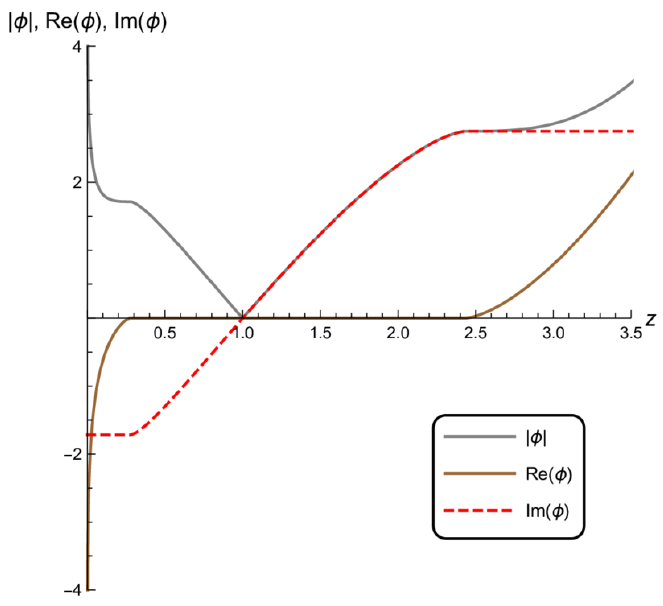
Figure 7 . Module, real and imaginary parts of the scalar (cid:12)eld (cid:30) for (cid:23) = 4 : 5, z h = 1, c = 1.